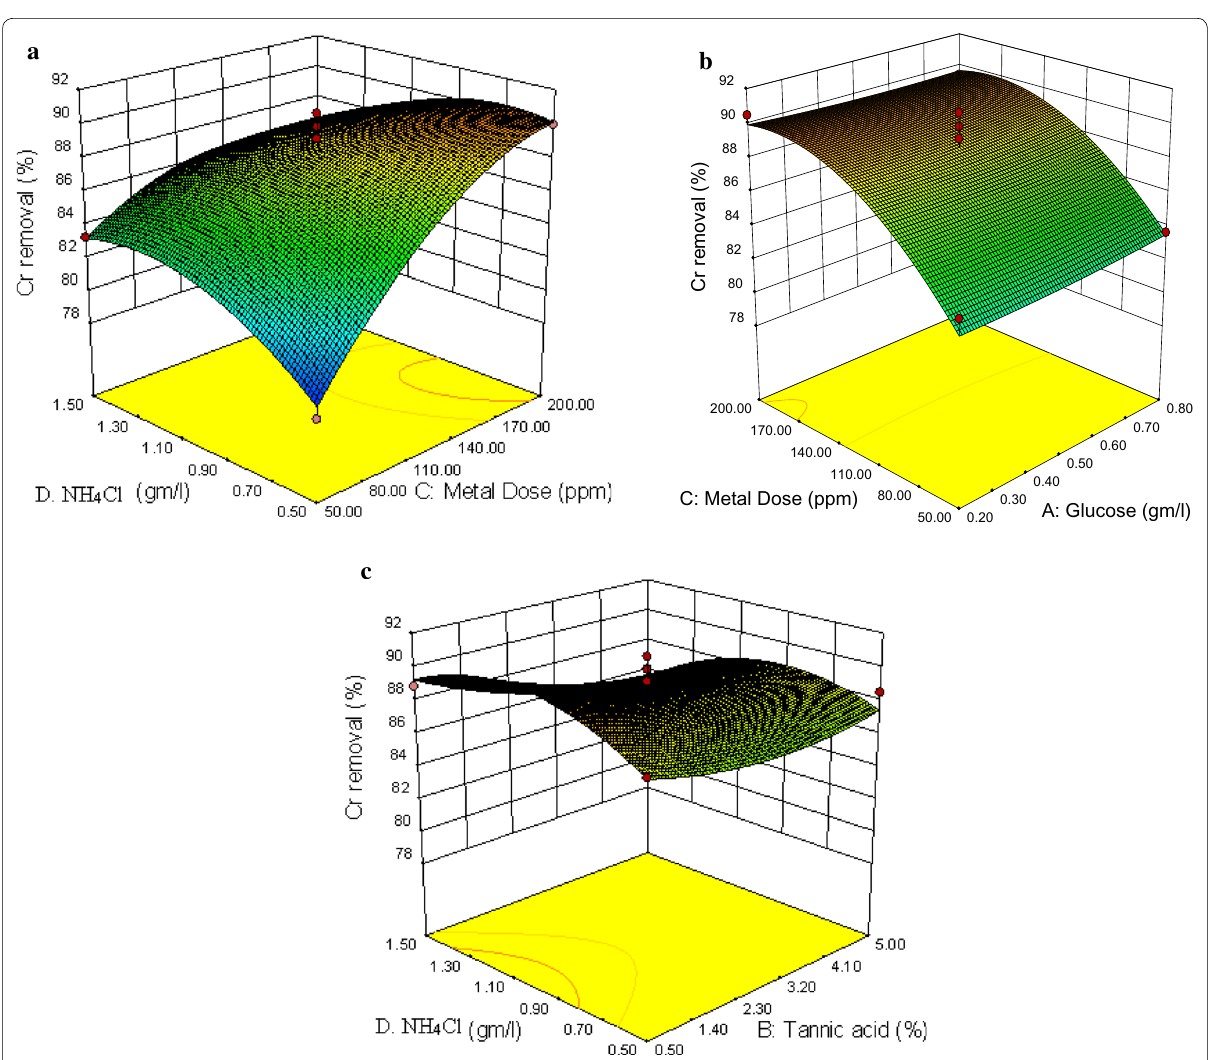
Fig. 3 Three dimensional plots of A. niveus . a Three-dimensional plot of residual Cr(VI) as a function of metal dose and glucose at constant tannic acid (2.75%) and NH 4 Cl (1 g/L). b Three-dimensional plot of residual Cr(VI) as a function of metal dose and tannic acid at constant glucose (0.5 g/L) and NH 4 Cl (1 g/L). c Three-dimensional plot of residual Cr(VI) as a function of NH 4 Cl and metal dose at constant glucose (0.5 g/L) and tannic acid